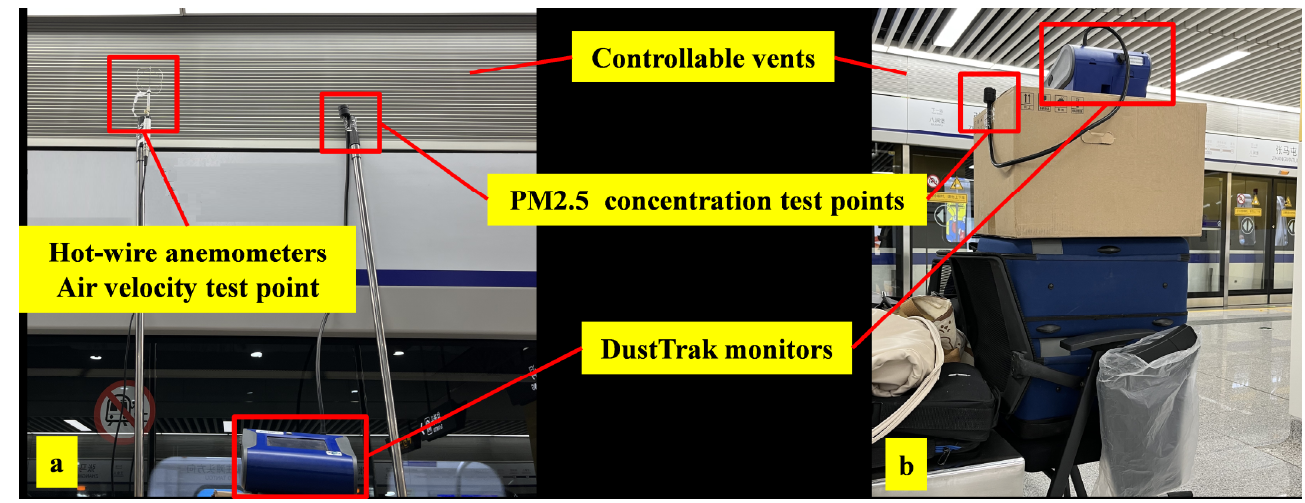
Figure 2. Photos of the test instruments’ layout: ( a ) Test point at a controllable vent. ( b ) Test point at the platform.